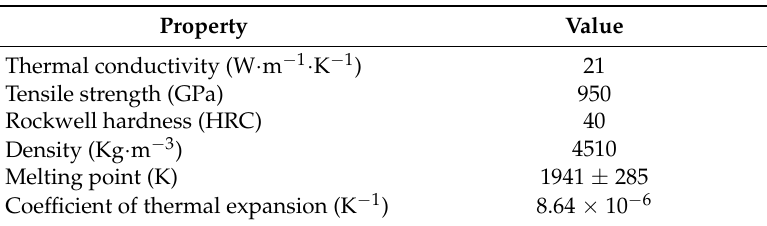
Table 2. Mechanical properties for